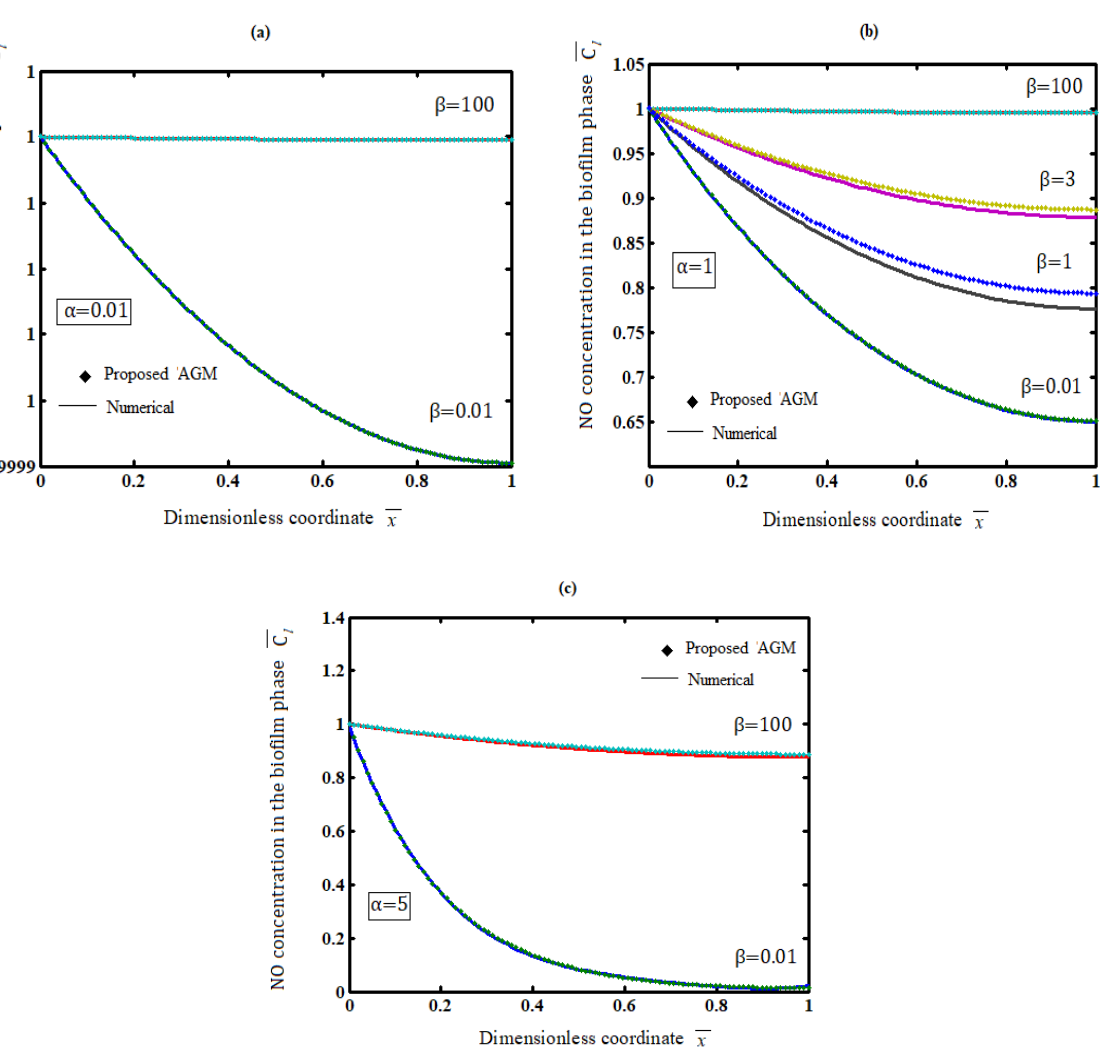
Figure 3. Dimensionless NO concentration in the biofilm phase C l computed using Equation (15) for various experimental (Table A2) values of β (when ( a ) α = 0.01 ( b ) α = 1 ( c ) α = 5.